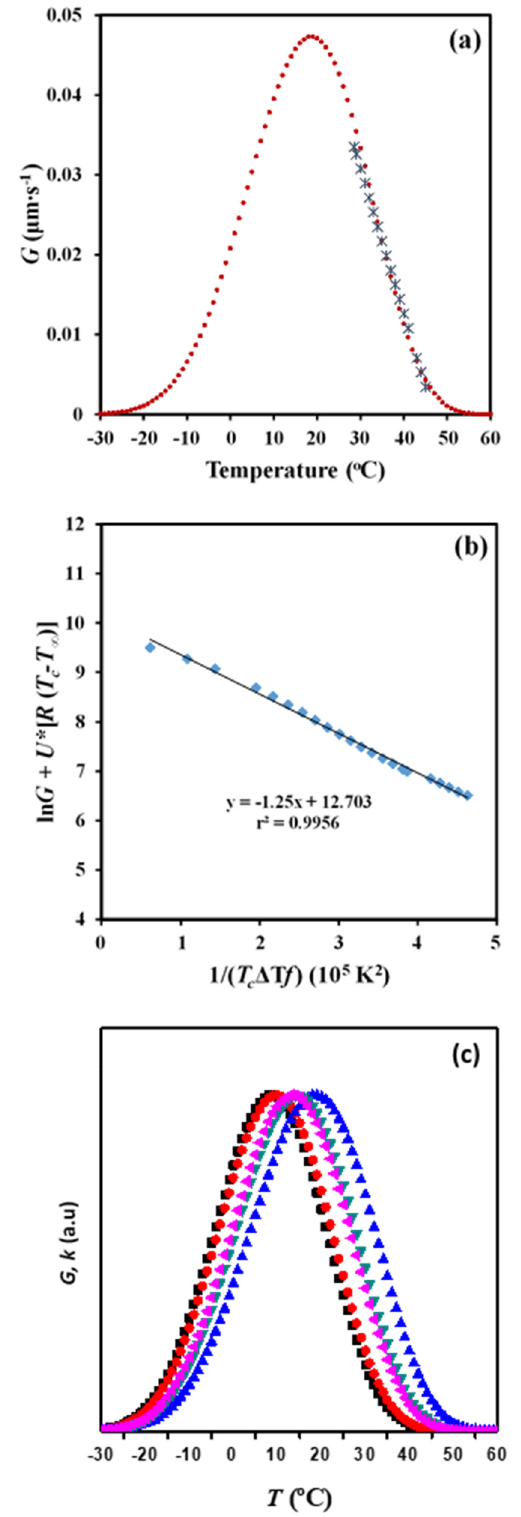
Figure 11. ( a ) Experimental and simulated dependence of the growth rate on crystallization temperature. ( b ) Plot of ln G + U */ R ( T c − T ∞ ) versus 1/ T c ( Δ T ) f to determine the K g secondary nucleation parameter of P4HB. ( c ) Comparison between bell-shaped curves derived from non-isothermal DSC data (( ● ) from isoconversional and ( ■ ) from Avrami analyses), non-isothermal OM data ( ▲ ) and isothermal DSC data ( ◄ ) and OM ( ▼ ) data.